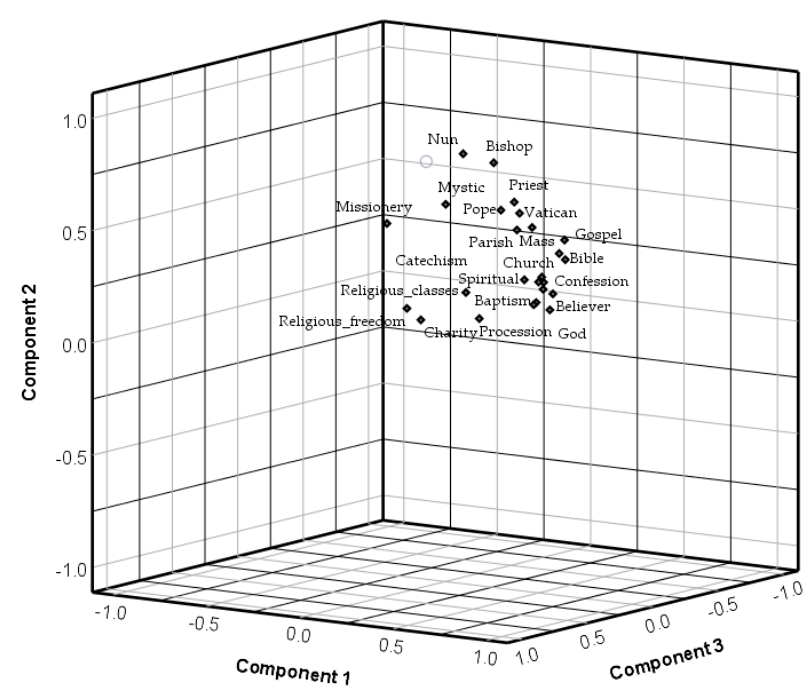
Figure 2. Figure of rotated components in